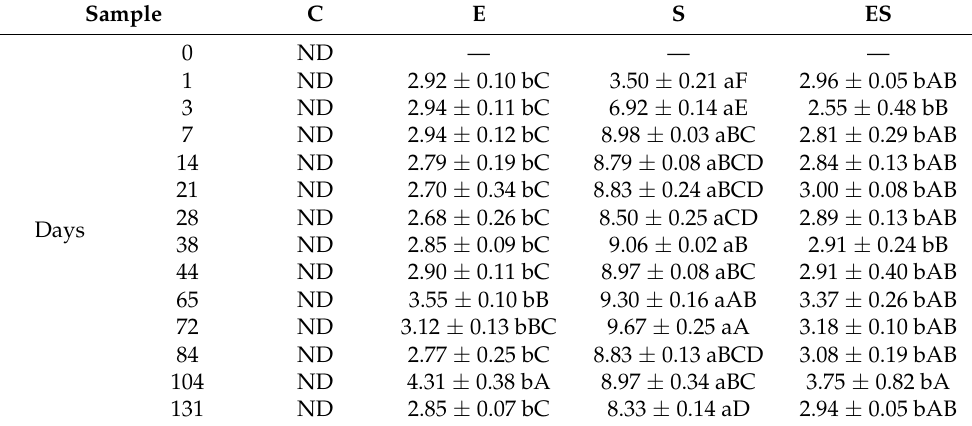
Table 12. Growth of AMB (log cfu/g) in fish broth during storage for 131 days: without inoculum (C); with 8% ethanol-water extract (E); with inoculum (S); and with 8% of extract and inoculum (ES).